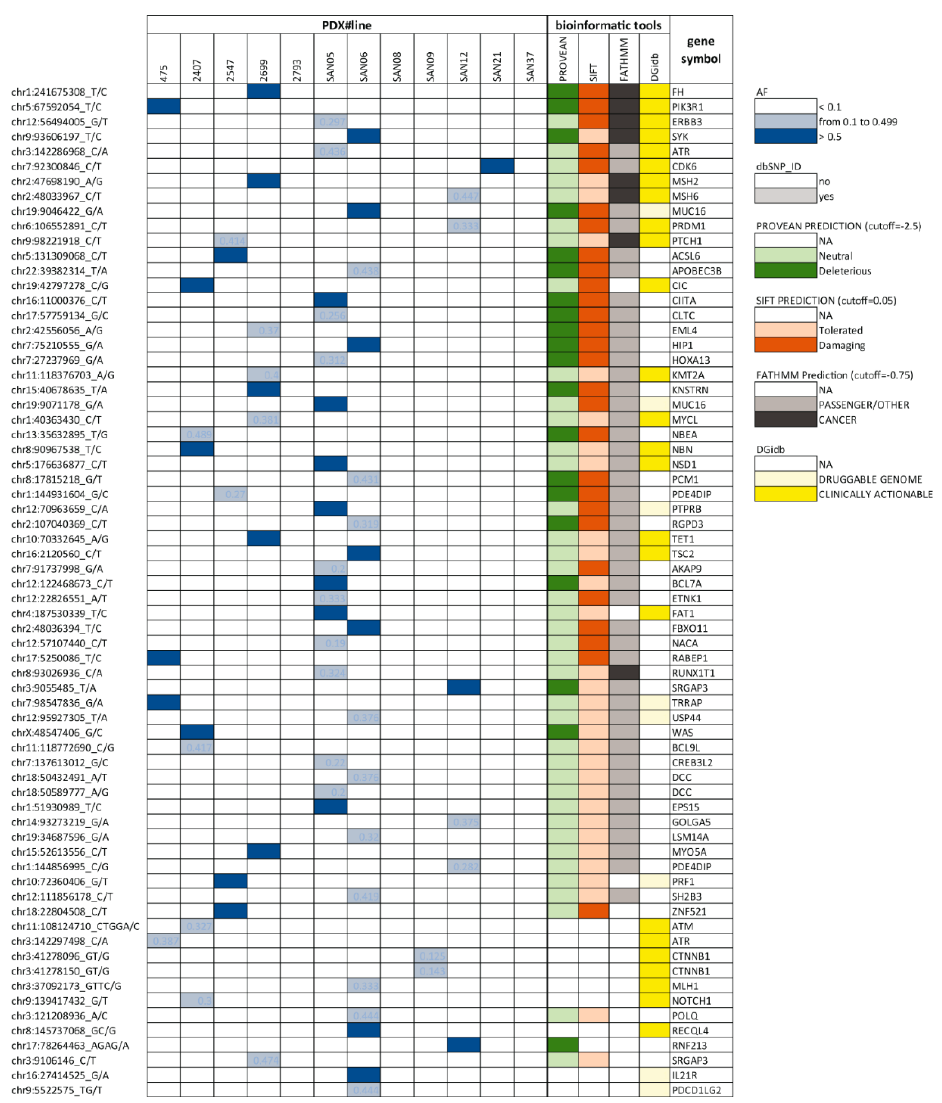
Figure 2. Single Nucleotide Variants (SNVs) in cancer genes found in PDX lines derived from naïve HGS-EOC. Variants with an allele frequency (AF) ≥ 0.1 are listed. Only SNVs not classified as